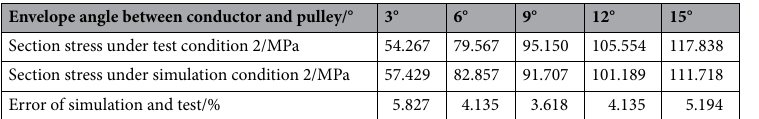
Table 14. Data comparison between the simulation condition 2 and the test condition